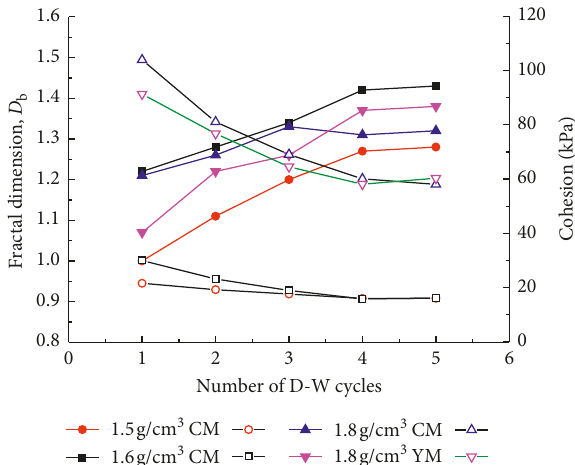
Figure 5: Variations of cohesion as well as fractal dimension with the number of D-W